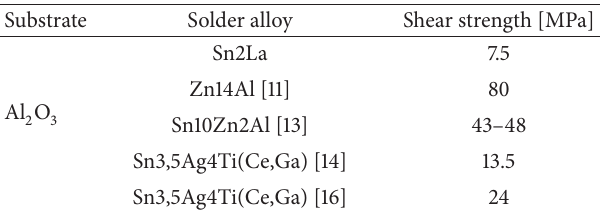
Table 2: Comparison of achieved shear strength of Al 2 O 3 /solder